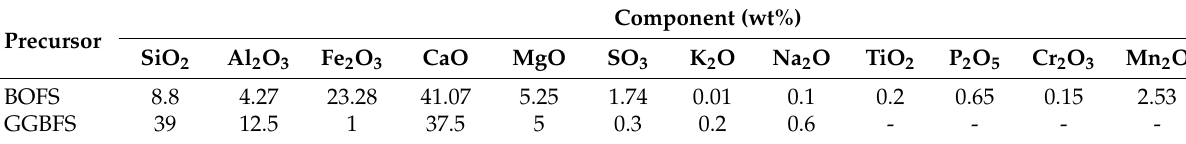
Figure 2. SEM photographs of ( a ) BOFS and ( b ) GGBFS.